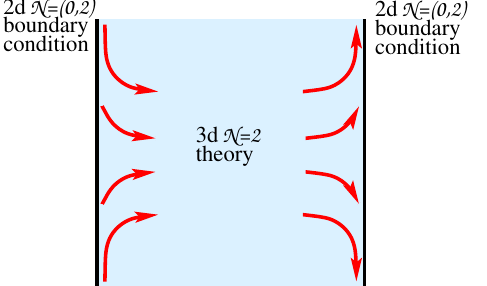
Figure 3 . An illustration of the anomaly in(cid:13)ow in 3d N = 2 theory with 2d N = (0 ; 2) boundary conditions. For example, if one boundary carries charged chiral fermions whose anomaly is com- pensated by Chern-Simons couplings of the 3d bulk theory, a similar mechanism must be at work at the other